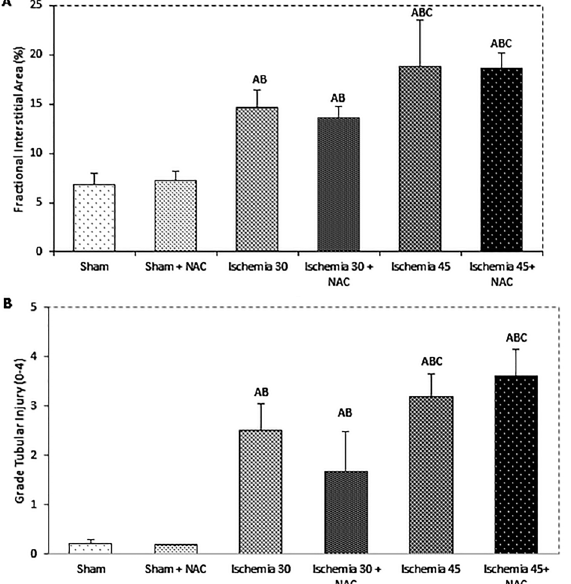
Figure 2. Effect of n-acetylcysteine (NAC) on renal histological analysis. Data are reported as means ± SE. A P o 0.001 vs SHAM; B P o 0.001 vs SHAM + NAC; C P o 0.001 vs Ischemia 30 min